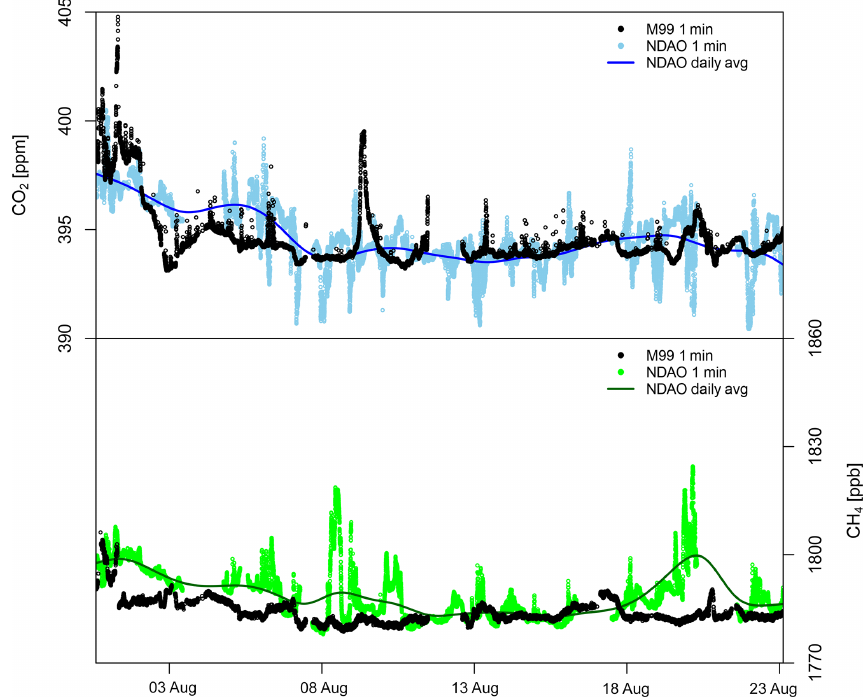
Figure 6. Time series of atmospheric CO 2 and CH 4 during M99. Atmospheric observations of CO 2 and CH 4 during the M99 cruise. Black points are the shipboard measurements and colored points are the NDAO measurements. Also shown for both species is a smooth fit to a rolling daily average. The diurnal variability was caused by a sea breeze–land breeze dynamic, with lower CO 2 mole fractions and higher CH 4 mole fractions occurring at night during the land breeze. Table 2. Comparisons of top-down and underway flux density estimates for the M99 upwelling event (9 August 2013) Species Unit Top-down Shipboard ( k W14